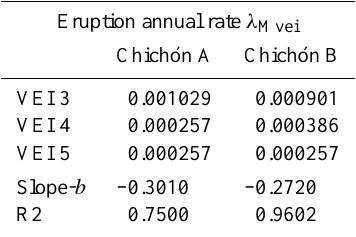
Table 5. Eruption rates λ Mvei for each VEI class, the slope- b of the loglinear relationships from Eq. (1), and the regression coefficients for the two models listed in the Table 3 for El Chich ´ on volcano in the period 7772years BLE.